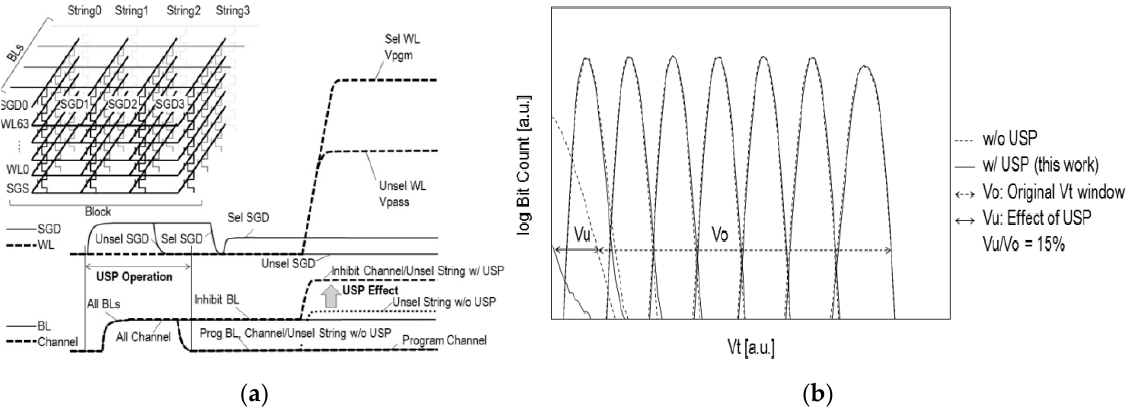
Figure 2. ( a ) Four strings in a block and USP sequence. Reprinted/adapted with permission from Ref. [21], 2017, IEEE. ( b ) Cell distribution using USP sequence. Reprinted/adapted with permission from Ref. [21], 2017, IEEE.